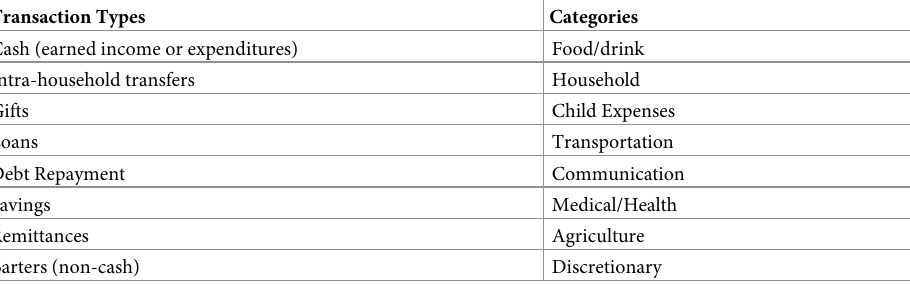
Table 2. Financial diary transaction types and categories.